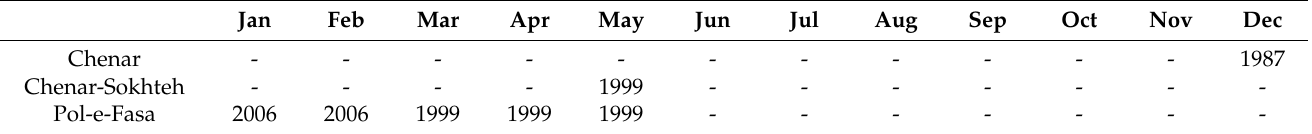
Note: These values were deemed statistically significant at α = 0.05. Table 6. Changing points detected in the monthly streamflow time series of selected stations.